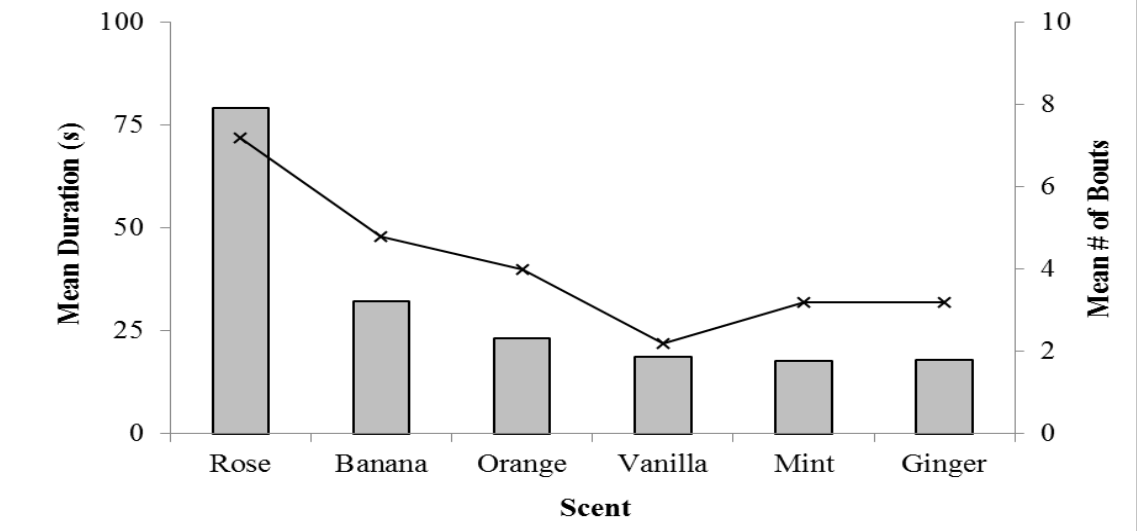
Figure 2. Differences in duration and number of bouts spent with each of the different